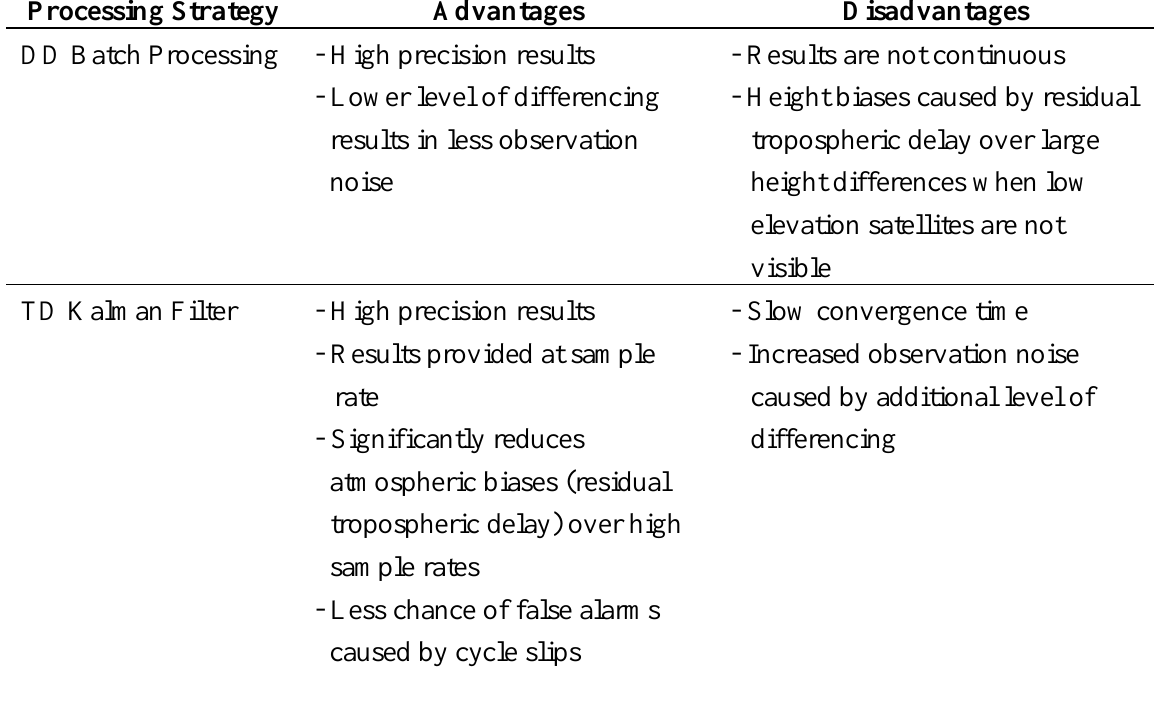
Table 1. Comparison of DD Batch Processing with TD Kalman Filter Processing